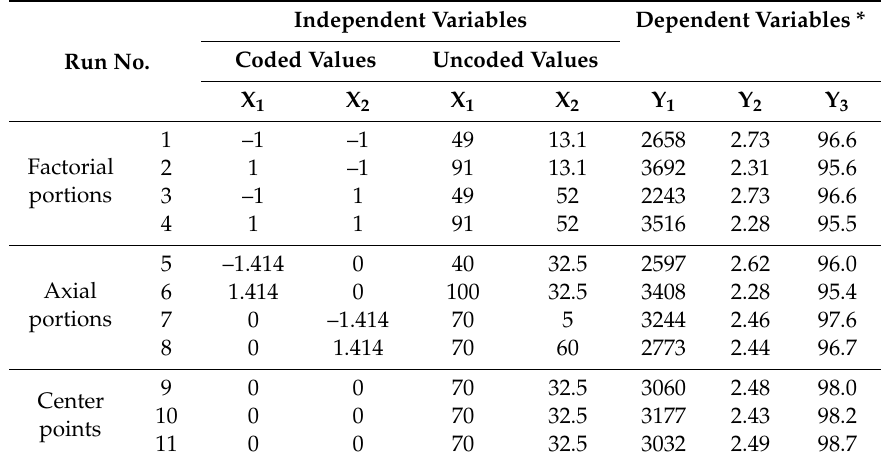
Table 2. Central composite design matrix and values of dependent variables for monitoring the e ff ects of thermal treatment on the physical properties of CAG beads.